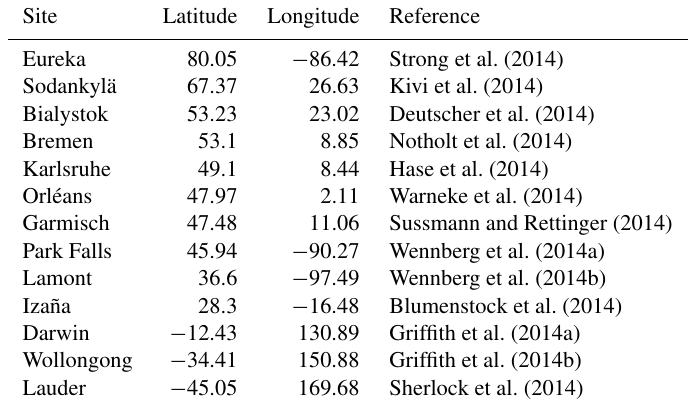
Figure 5. Column mean CO 2 for GEM-MACH-GHG with CT2013B fluxes (top row), CT2013B (middle row) and CT2013B minus GEM- MACH-GHG fields (bottom row) for 1 July 2009 (left column) and 31 December 2009 (right column). Table 1. TCCON stations used, their location and data